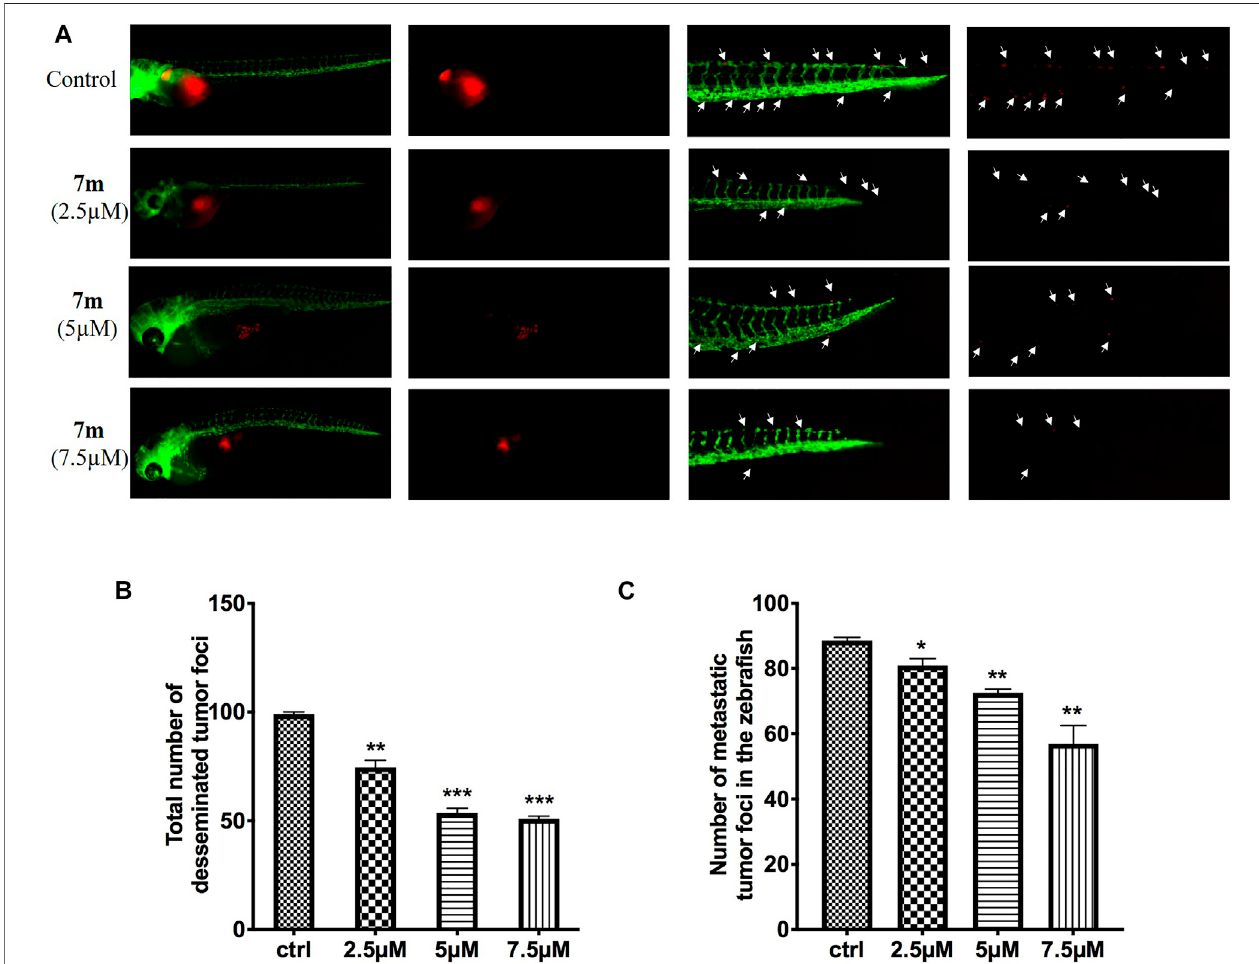
FIGURE 11 | (A) Inhibitory effects of 7m on the proliferation and metastasis of MCF-7 cells in zebra fi sh xenograft models. CMTPX-labeled MCF-7 cells (red) were microinjected into zebra fi sh embryos, and indicated concentrations of 7m were added. (B) Quanti fi cation of the fl uorescent area of the tumor xenografts, representing total MCF-7 cells in zebra fi sh. (C) Fluorescence intensity of the tumor xenografts in trunk.